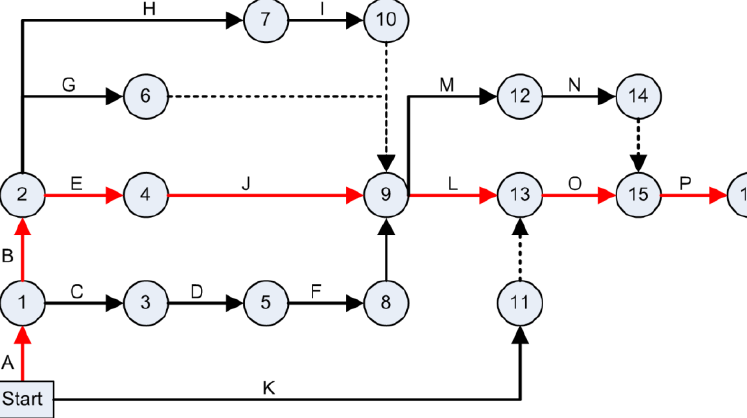
Figure 5. Network diagram for the project. Table 2. The earliest start, earliest finish, latest start, latest finish times, and slack activities of the Reex project.